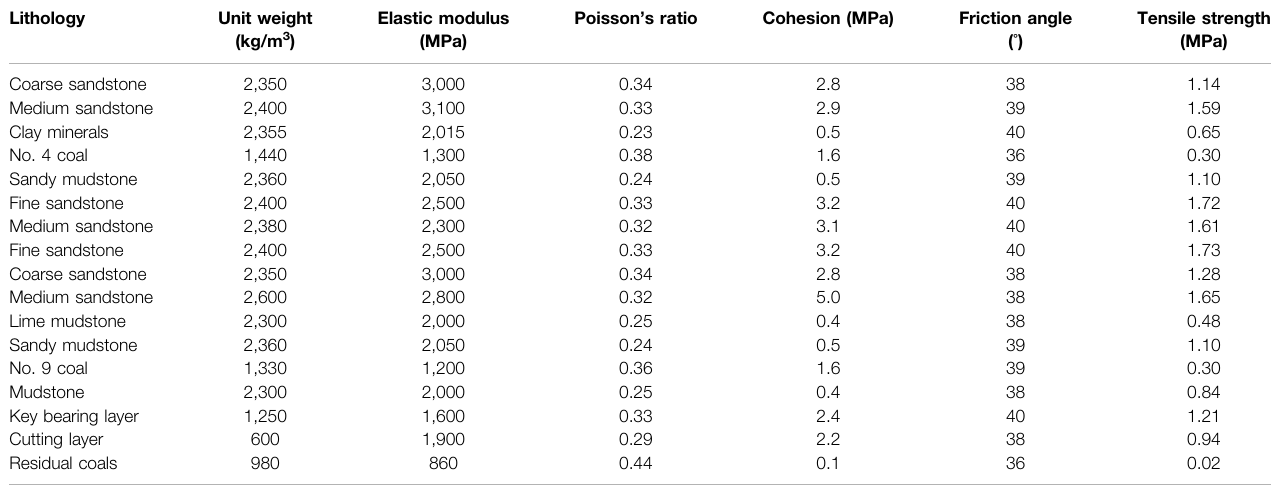
TABLE 3 | Numerical simulation calculation parameters. Lithology